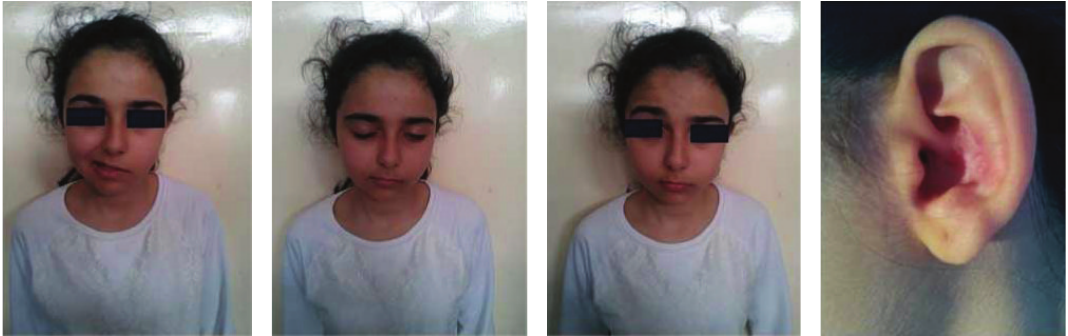
Figure 2: A 12-year-old female with left facial paralysis and a vesicular lesion in the left